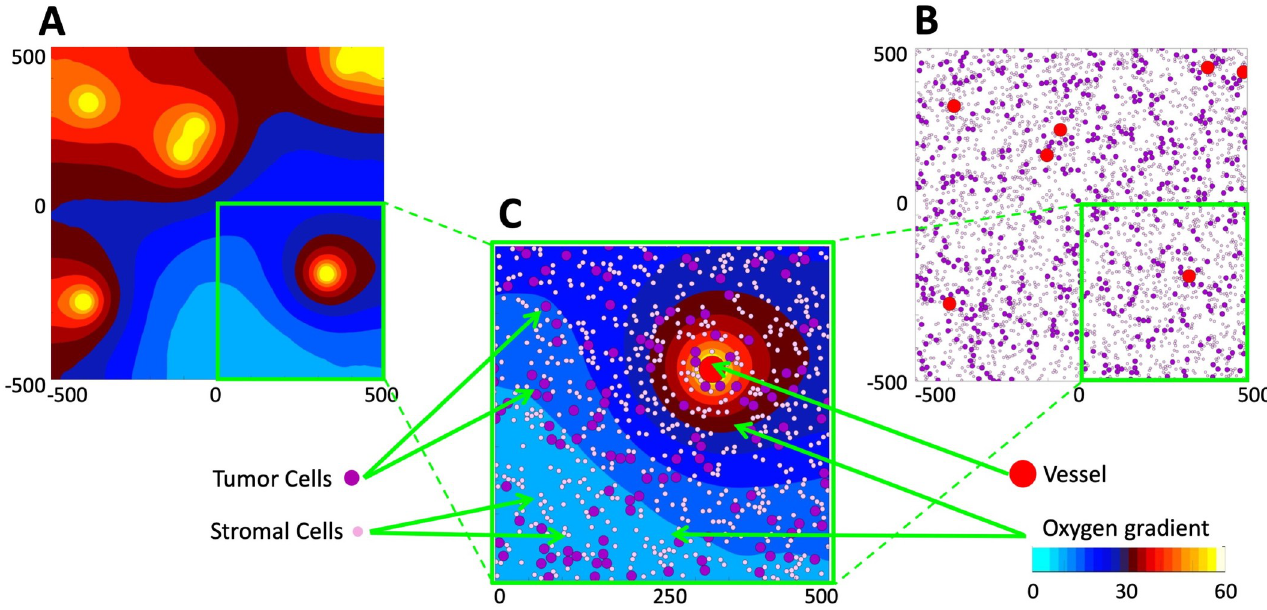
Fig 1. Mathematical model of the tumor tissue microenvironment. A. A contour map of the simulated oxygen distribution. The color scheme corresponds to that used in EPR imaging for the partial pressure of oxygen (cyan: low pO 2 ; white: high pO 2 ). B. Locations of tumor vasculature (red circles), tumor cells (purple circles), and stromal cells (pink circles) within the same computational domain; this is used to define tissue cellularity and vascularity. The color scheme corresponds to typical colors in histology images. C. Magnification of a quarter of the computational domain showing all model components together: the vessels, tumor and stromal cells, and oxygen distribution. All variables are dimensional (length is in μm , oxygen partial pressure in mmHg , as listed in Table 1).